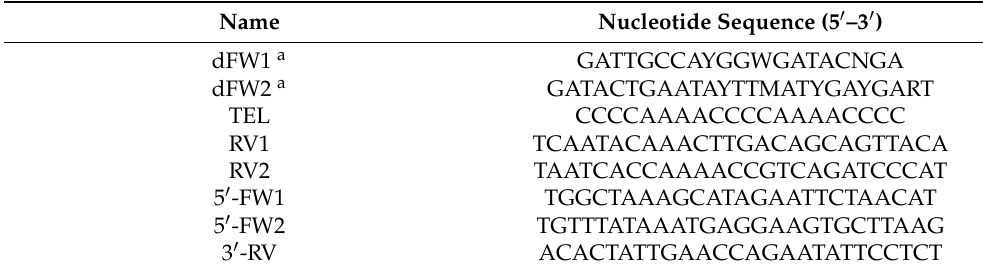
Table 1. PCR primer designation and